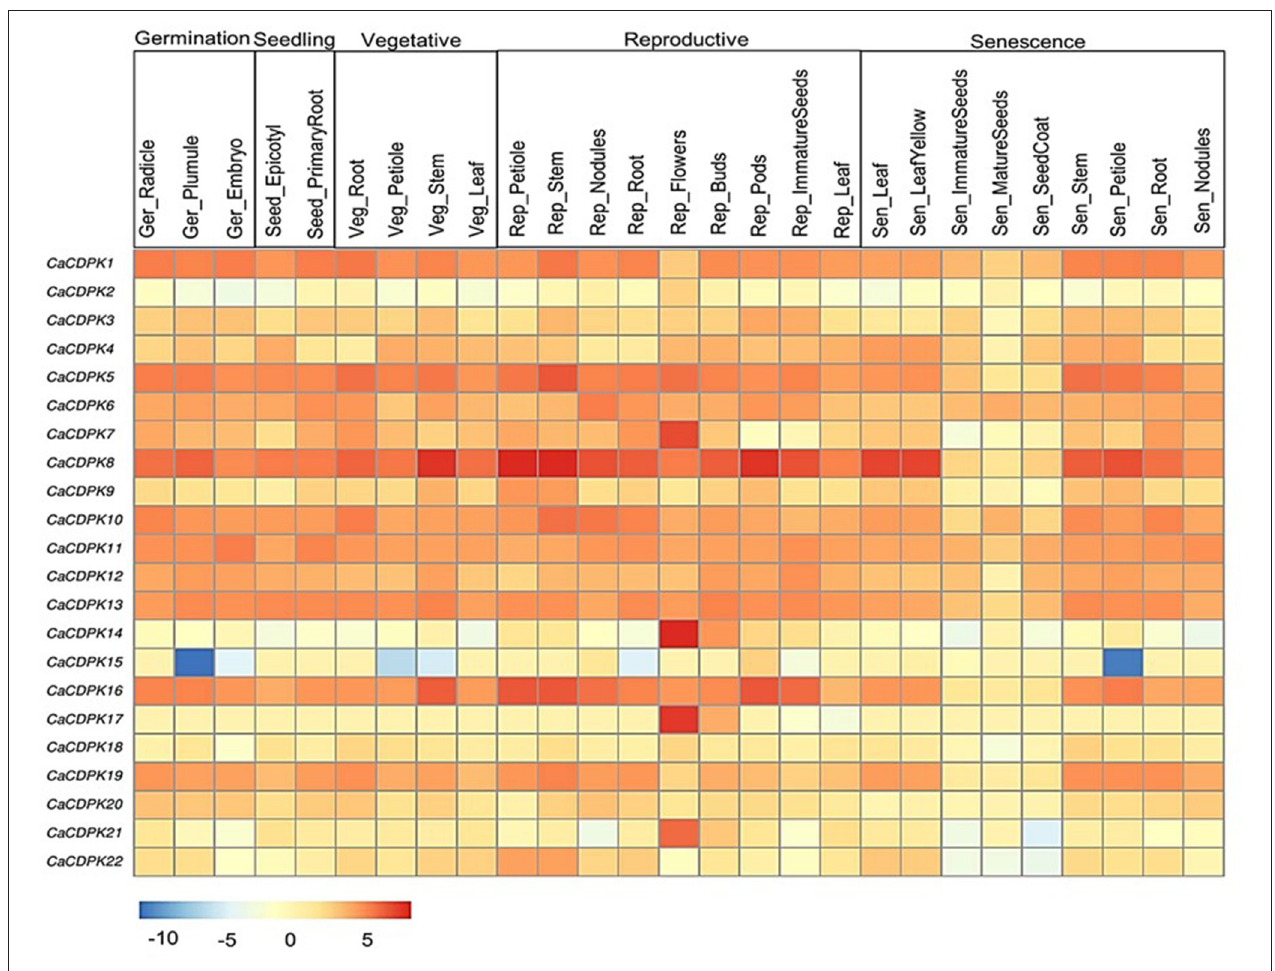
FIGURE 7 | Expression profiles of CDPK genes in different developmental stages of chickpea. The heatmap represents the expression pattern of CaCDPK genes in different tissues of developmental stages, such as germination, seedling, vegetative, reproduction, and senescence. The genes are named on the left and different tissues/developmental stages are labeled at the top. Scale bar represents the normalized log_2 FPKM